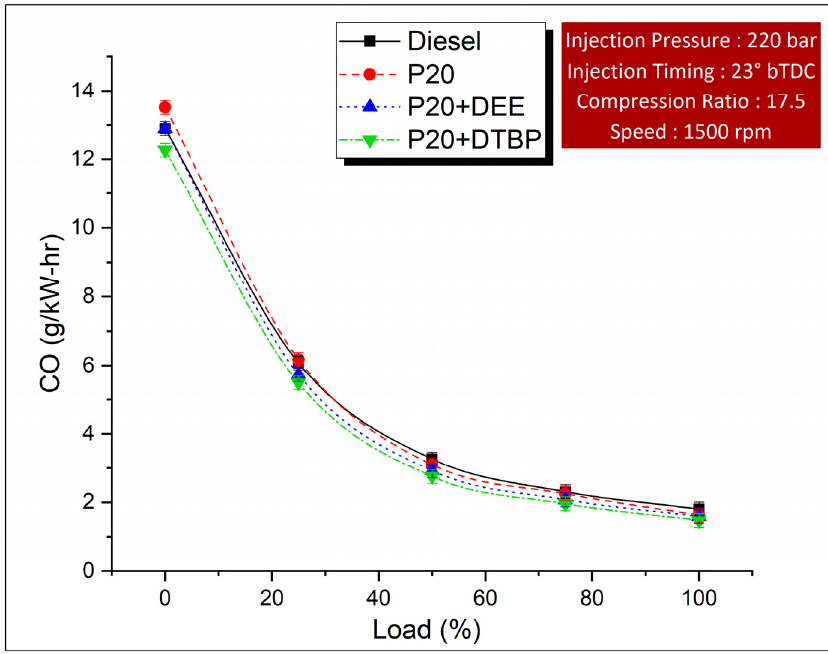
Figure 7. CO variation for test fuel blends at different load condition